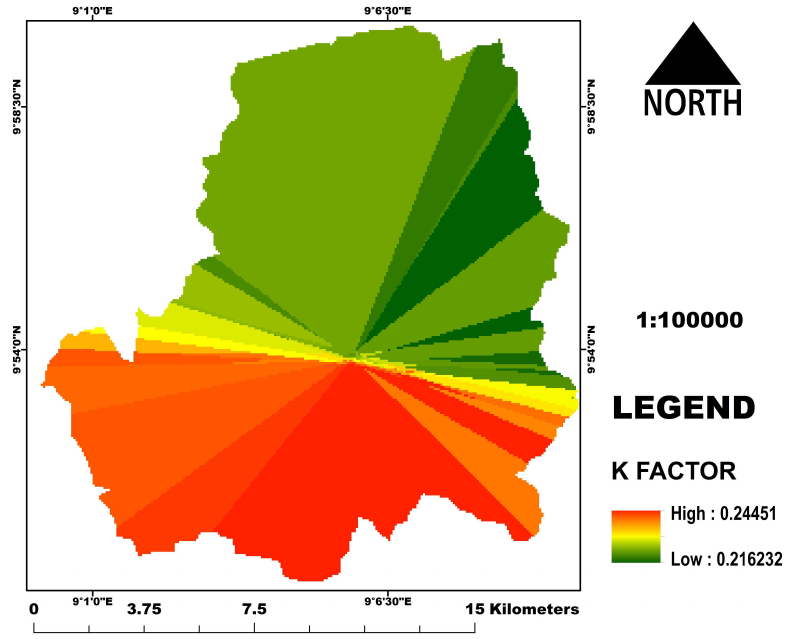
Figure 9. The K factor map.